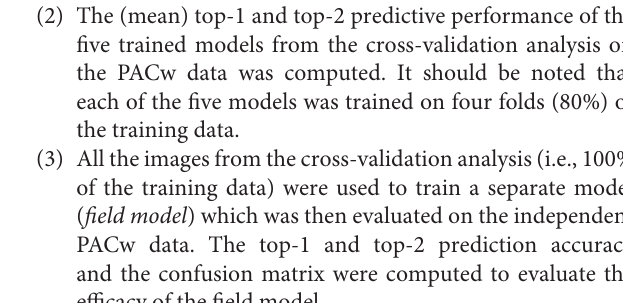
FIGURE 2 | Model schematic. (A) The CNN architecture for our 22-class wood identification models consisted of a ResNet34 backbone with a custom classifier head. The custom head shown in panel (B) is comprised of global average (A) and max (M) pooling (Goodfellow et al., 2016) layers that are concatenated (C) to form a 1024-vector. This is followed by two fully connected blocks (B 1 , B 2 ) each with batchnorm (Ioffe and Szegedy, 2015) and dropout (Srivastava et al., 2014) layers. The dropout layers had parameters p = 0.5 and p = 0.25 in the B 1 and B 2 blocks, respectively. ReLU activation was used in B 1 , while B 2 had a softmax activation. The status of the weights of the backbone and custom head, whether they are modified or not during the two stages of training, are represented by the lock and unlock symbols,